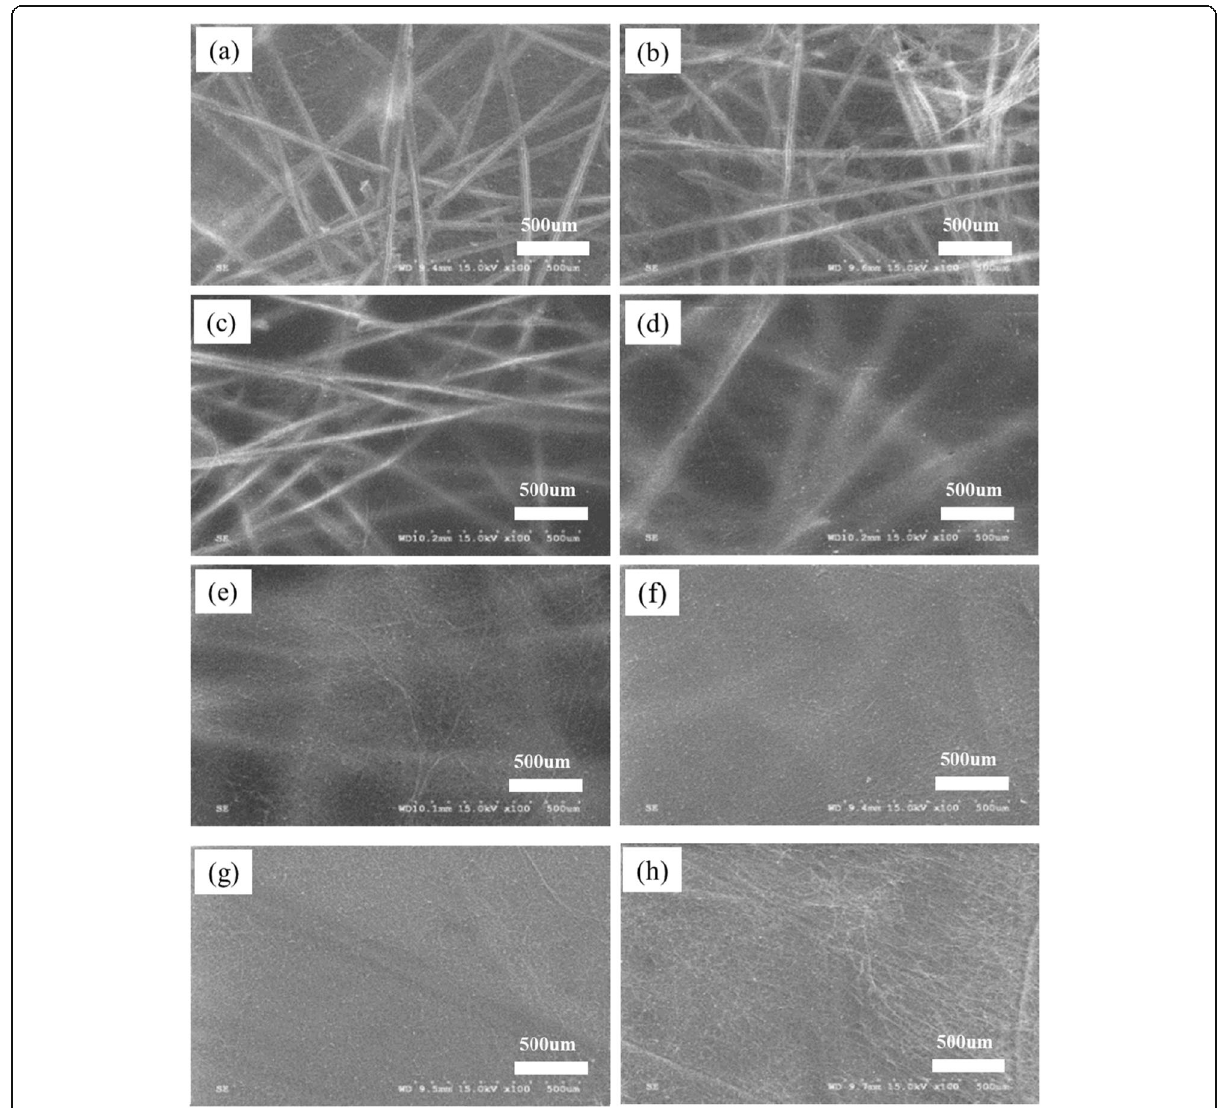
Fig. 2 Morphology of PAN:TiO 2 nanofiber membranes with different spinning times (different thicknesses): a 15 min, b 30 min, c 45 min, d 1 h, e 2 h, f 4 h, g 6 h and h 8